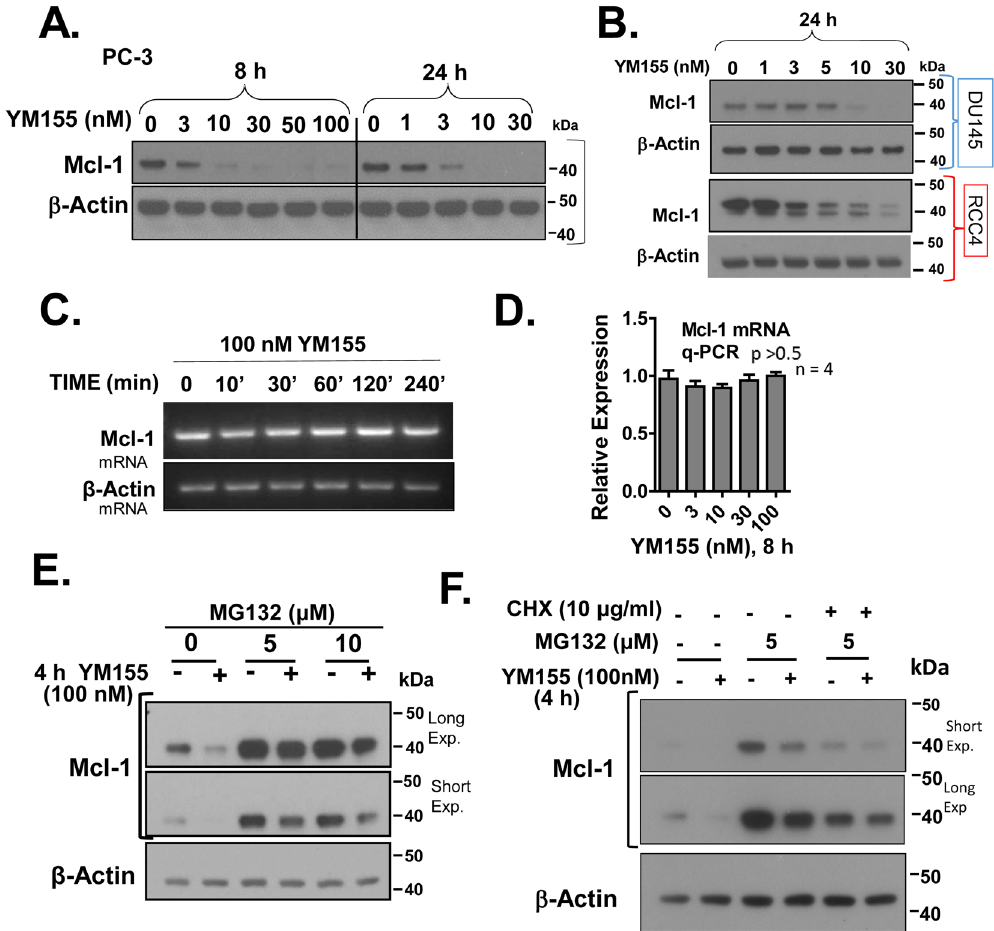
Figure 4. YM155 suppresses Mcl-1 protein levels, but not mRNA levels and such protein may occur partly through a proteasomal-independent mechanism. ( A , B ) PC-3, DU-145, and RCC4 cells were treated with the indicated concentrations of YM155 for 8 and 24 h, and Western blotted for Mcl-1 and β -Actin. ( C , D ) Effect of YM155 on Mcl-1 mRNA expression in PC-3 was assessed by semi-quantitative RT-PCR ( C ) and quantitative real-time PCR ( D ). ( E ) PC-3 cells were pretreated for 30 min with 5 or 10 µ M MG132, followed by treatment with 100 nM YM155 or vehicle for 4 h, after which cells were subjected to Western blotting for expression of Mcl-1 and β -Actin. ( F ) The combined effect of MG132 and CHX (30 min) on the YM155-induced suppression of Mcl-1 in PC-3 cells after 4 h, assessed by Western blot. Unless indicated on the figure, each group of blots represents data obtained from a single gel and experiment. Results shown are representative of 2 to 3 independent